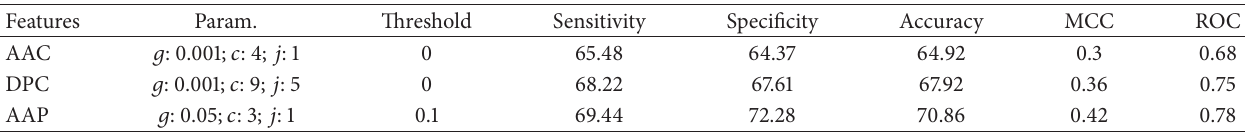
Table 5: The performance of SVM models developed on alternate dataset using various compositional features of peptides on rbf-kernel. Features Param. Threshold Sensitivity Specificity Accuracy MCC